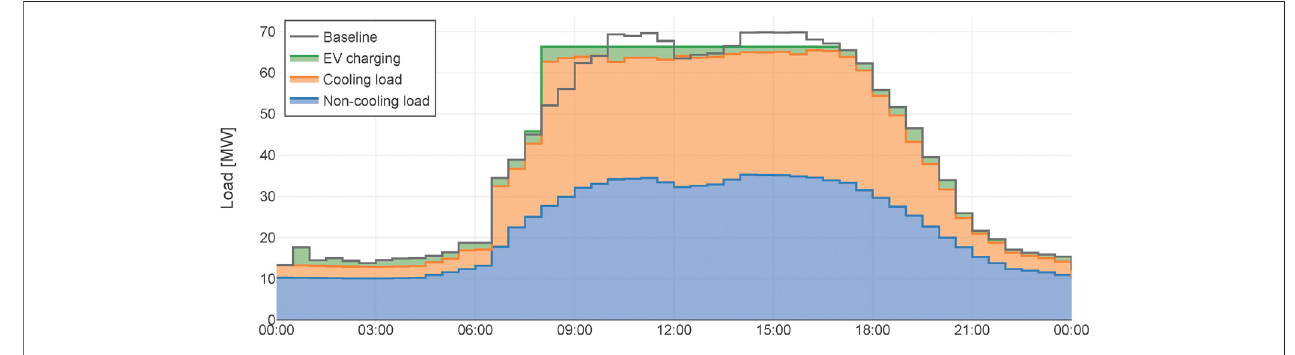
FIGURE 14 | Demand-side management: peak shaving of 5% through